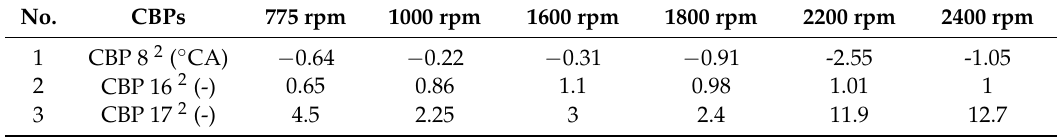
Table 10. Evaluated CBPs (Table 1) in calibration loop 3 at part-load operating